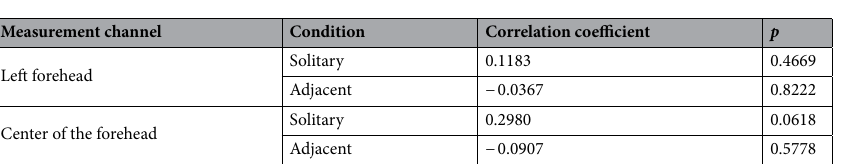
Table 3. Results of correlation analysis between reaction time and task-related signal changes for each measurement channel and condition. p indicates the probability that the correlation coefficient is not significantly different from 0 (two-sided test). Because four correlation coefficients were obtained, the significance level corrected for a multiple comparison was set at p < 0.0125.